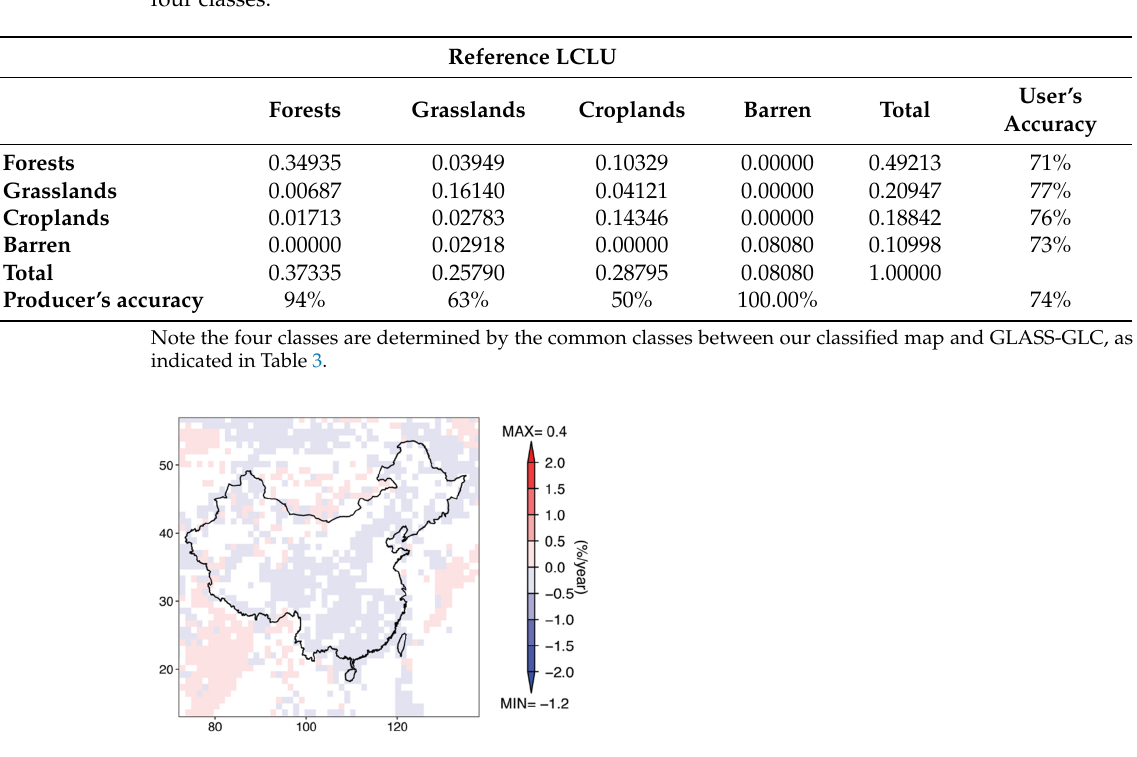
Figure A3. Temporal changes for the total areas of urban and built-up, cropland/natural vegetation mosaic, barren, and water bodies in the EASM region from 1982 to 2015 (The forest class includes evergreen broadleaf, deciduous needleleaf, deciduous broadleaf, and mixed forests as well as woody savanna and savanna, as presented in Table 6; The unit of the change is km 2 /year; *, **, and *** represent 10%, 5%, and 1% significant level, respectively).